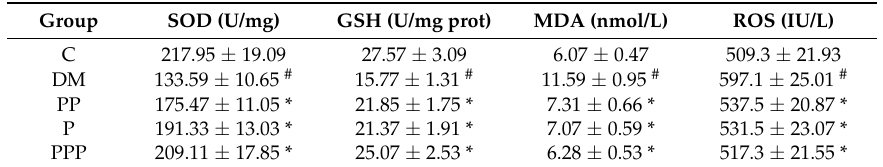
Table 3. The effect on oxidative